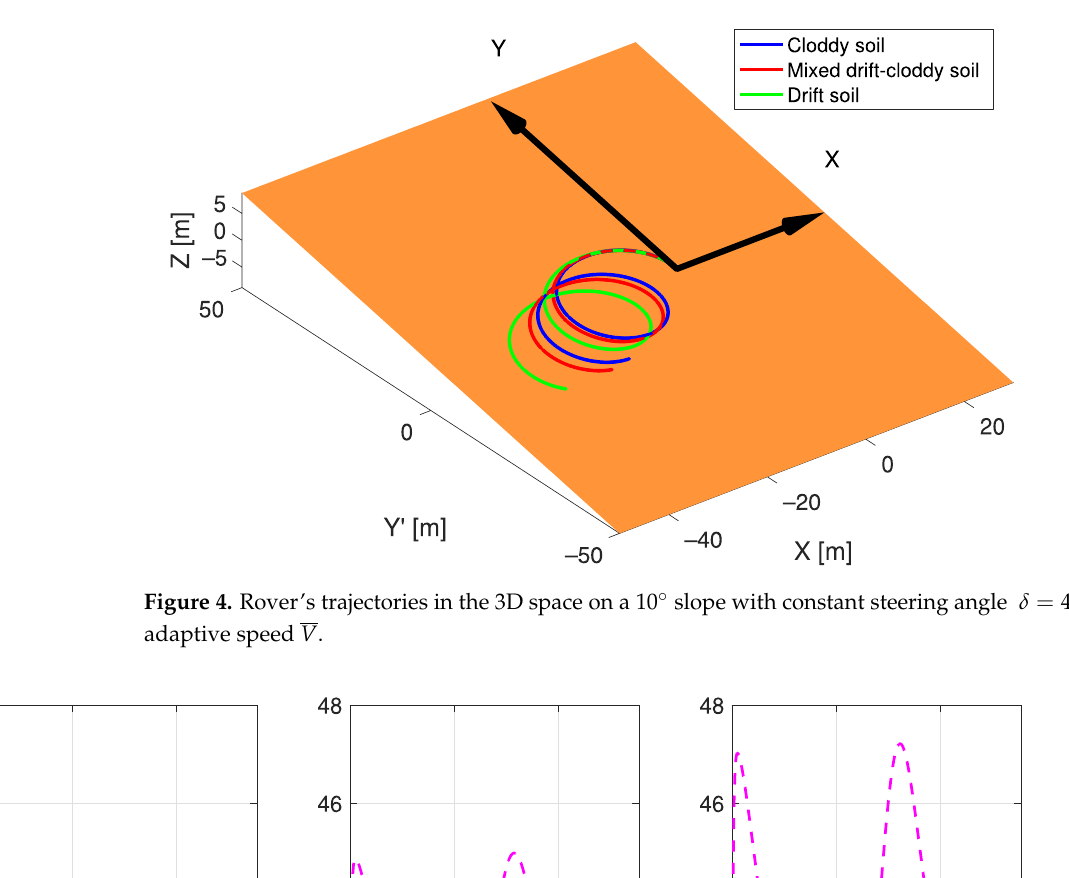
Figure 6. Rover’s longitudinal slip 𝜎 on a 10° slope, with constant steering angle 𝛿 = 4° and adaptive speed 𝑉̅. A second case is based on the trajectory integration with the same vehicle’s steering angle and initial state conditions on a steeper surface with a 20° slope. This terrain incli- nation is an upper limit constraint on ExoMars traverse. Its onboard path planning stand- ard will avoid slopes ≥ 20° [25]. The rover’s paths with a steeper terrain are dramatically